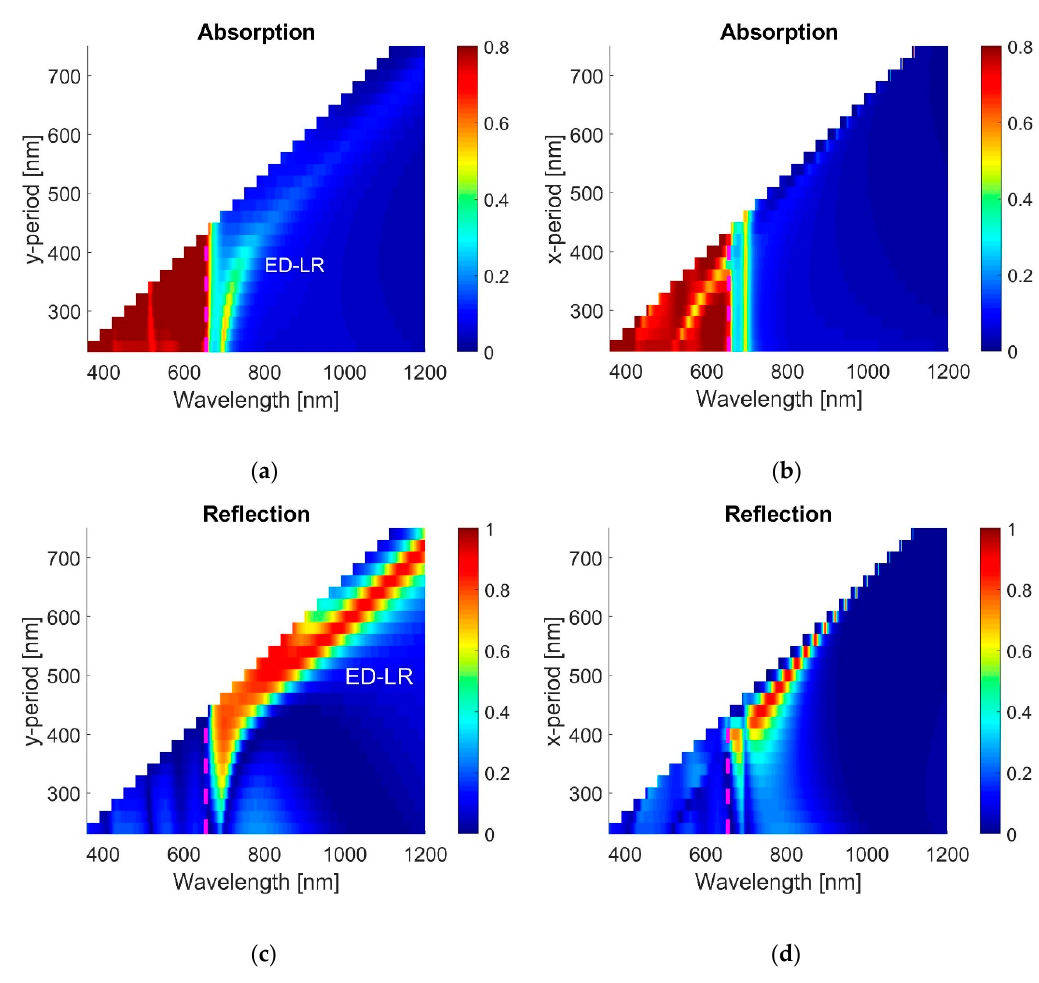
Figure 2. ( a ),( b ) Absorption and ( c ),( d ) reflection in nanoparticle array for different periods. In (a) and (c) period p y changes and p x = 240 nm. In (b) and (d), period p x is changes and p y = 240 nm. Magenta dashed lines indicate the same wavelength of absorption drop λ c as in Figure 1. Electric dipole lattice resonances (ED-LRs) appear for a change of the period p y , which is in full agreement with the analytical considerations for incident field E along the x -axis. Calculation results are terminated at Rayleigh anomaly wavelength λ RA = np x,y to account for only sub-diffraction effects.